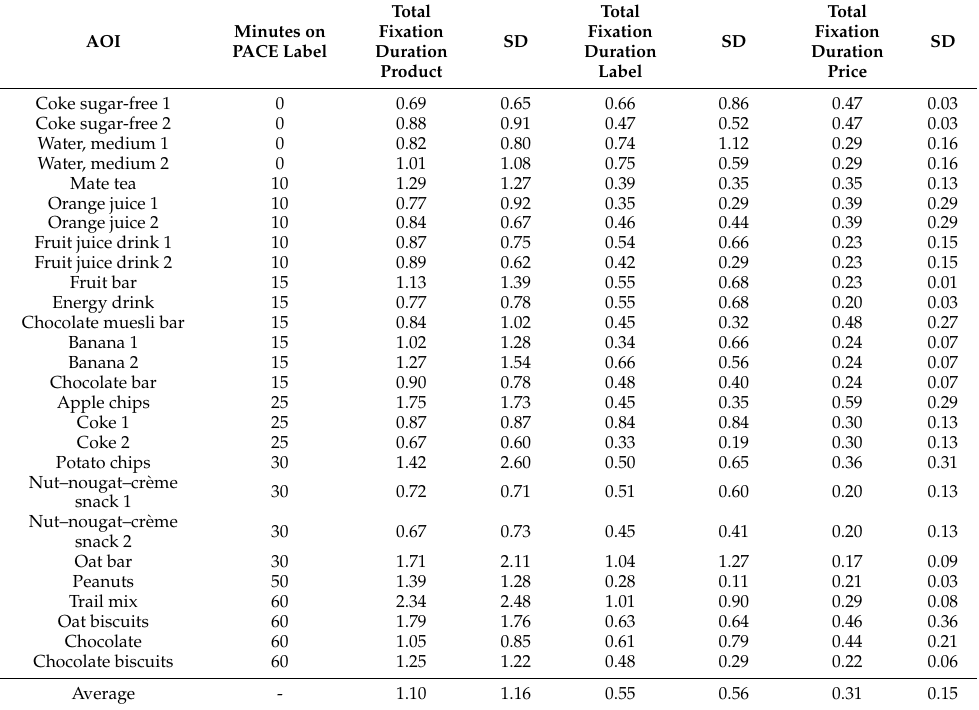
Table A3. Total fixation duration (TFD) and standard deviation (SD) of the products, the PACE labels and the price signs (in seconds). Within the table, the data are sorted based on the minutes that were declared on the PACE label of the